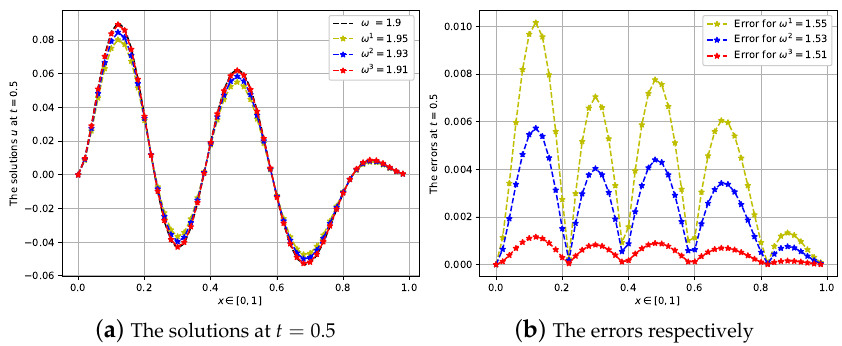
Figure 11. The solution u for ω = 1.9, ω i ∈ { 1.95,1.93,1.91 } at t = 0.5 and the respective error.